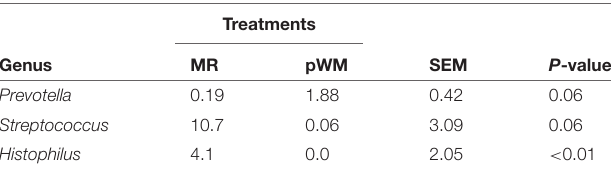
TABLE 3 | The relative abundance of genera in the core nasal microbiota of dairy calves fed either milk replacer (MR) or pasteurized waste milk (pWM). Treatments